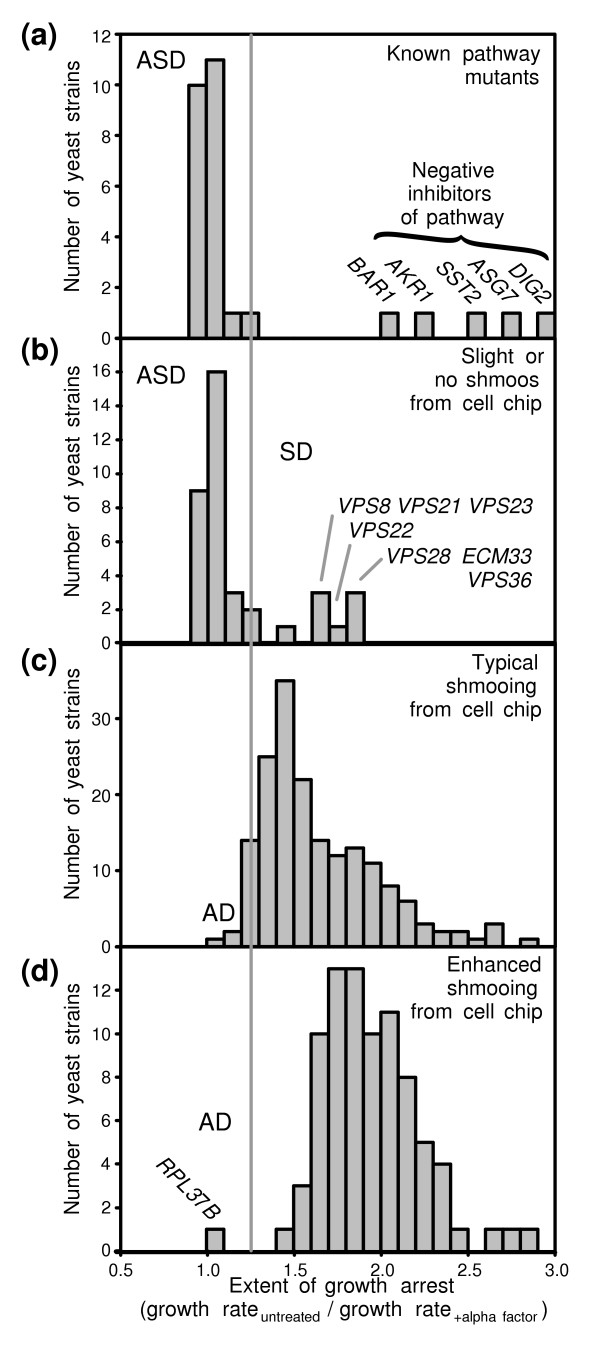
Results of a cell microarray-based genome-wide screen for genes participating in the mating-pheromone response pathway. Strains defective in the pathway fail to arrest growth when treated with alpha factor, unlike wild-type cells. The histograms report the average results of two or three replicate growth assays for (a) 28 strains containing deletions of genes known to participate in pheromone response, (b) 38 strains identified from cell microarrays as failing to shmoo properly, (c) 178 strains forming typical shmoos, and (d) 91 strains forming shmoos with a notably enhanced frequency in the cell population. The true-positive alpha factor-response pathway mutants (ASD, arrest+shmoo defective) are well separated from non-pathway mutants. Additional mutant categories identified were those defective only in the shmoo pathway (SD, shmoo defective), and those defective only in the growth arrest pathway (AD, arrest defective). Gene names indicate strains deleted for the corresponding genes.